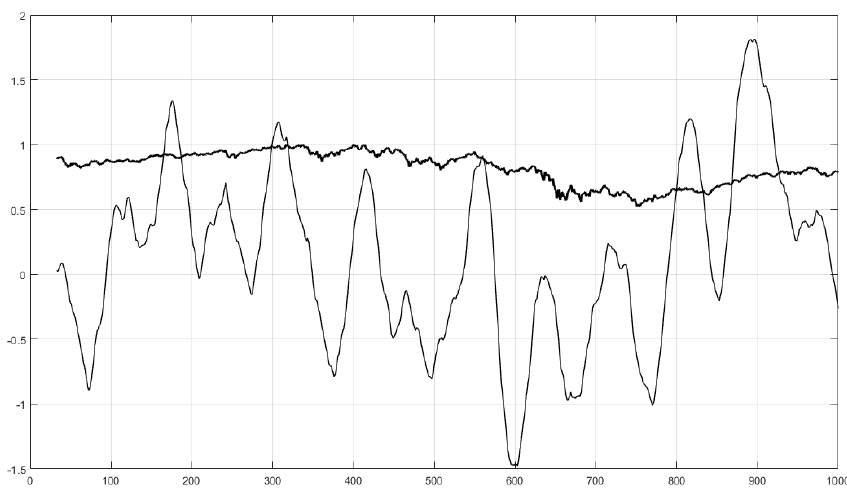
Figure 6. Example of computing the time dependent LVR λ σ (solid line —) for a normalised financial signal (bold solid line — ) with a look-back window of N =